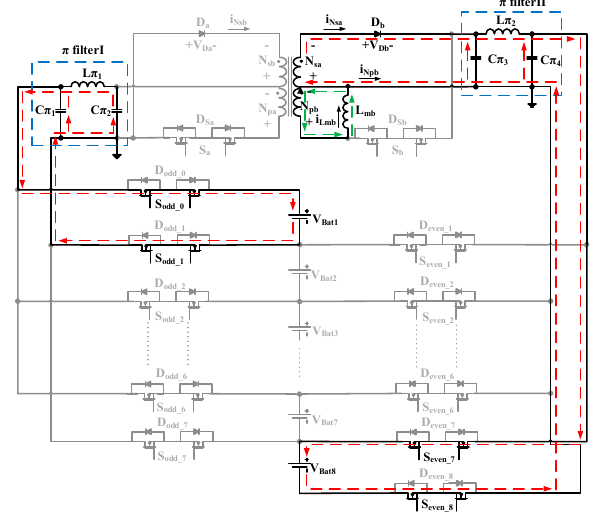
Figure 7. Mode II, the battery balancing process from higher V Bat8 to lower V Bat1 .